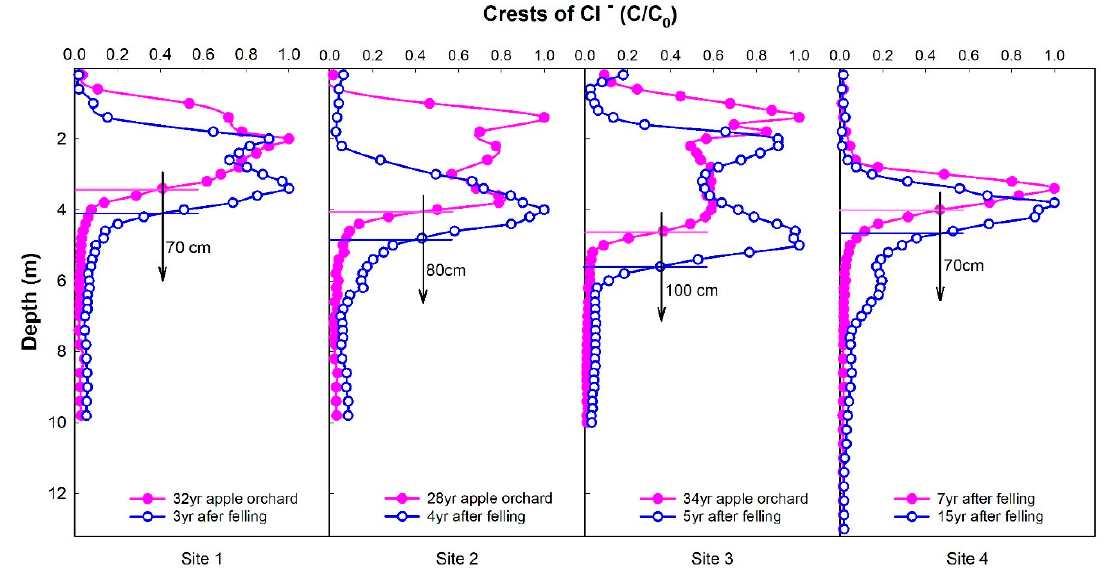
Figure 4. Movement of chloride crests in soil water. Table 1. Soil water recharge calculated according to the movement of chloride.